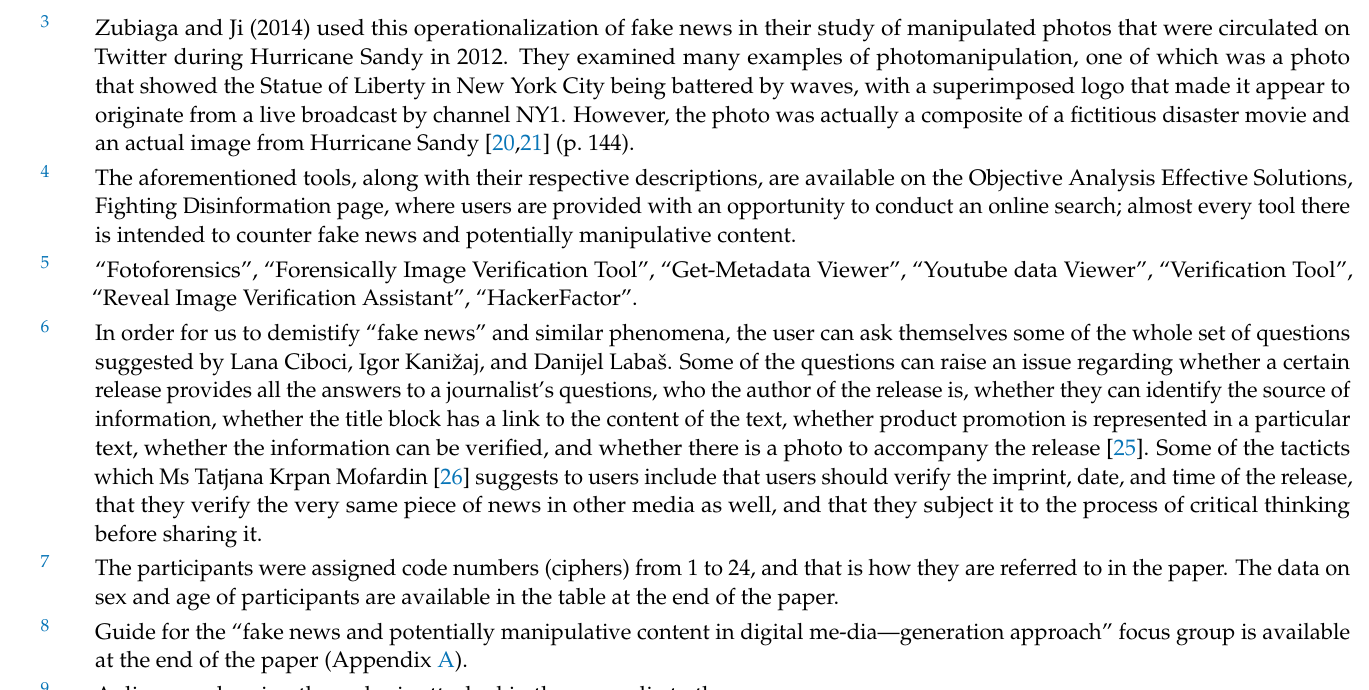
A diagram showing the codes is attached in the appendix to the